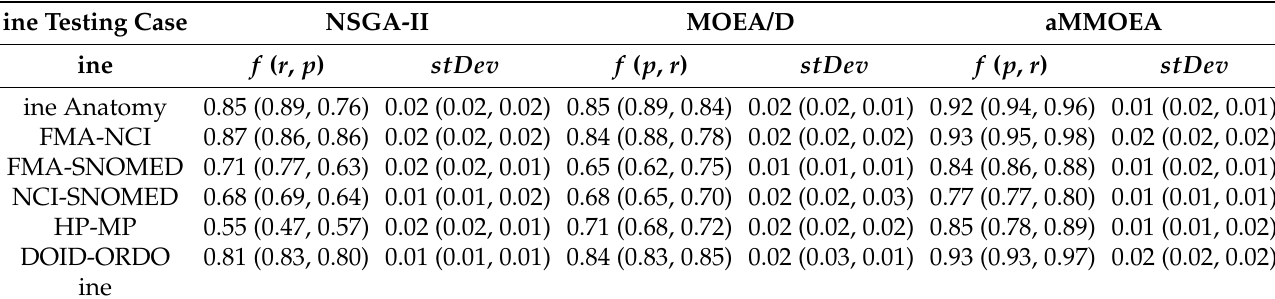
Table 3. Comparison among three MOEA-based matching techniques in terms of best f-measure (best recall and best precision) and standard deviation. The symbols f , r , p , and stDev stand for f-measure, recall, precision, and standard deviation, respectively.